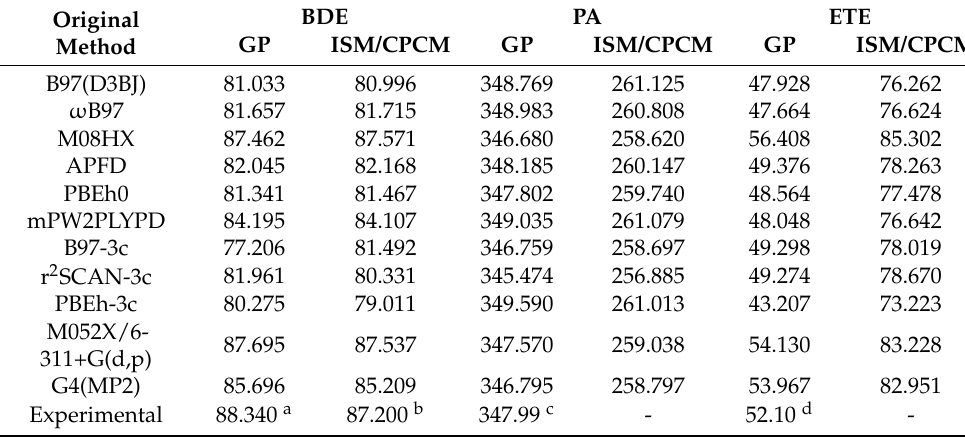
Table 1. The BDEs, PAs, and ETEs calculated using the original method approach, evaluating the first and second derivatives for each level of theory (in